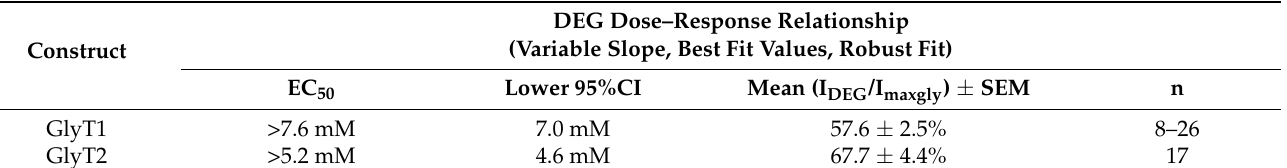
Table 3. Summary of electrophysiological data of DEG application.